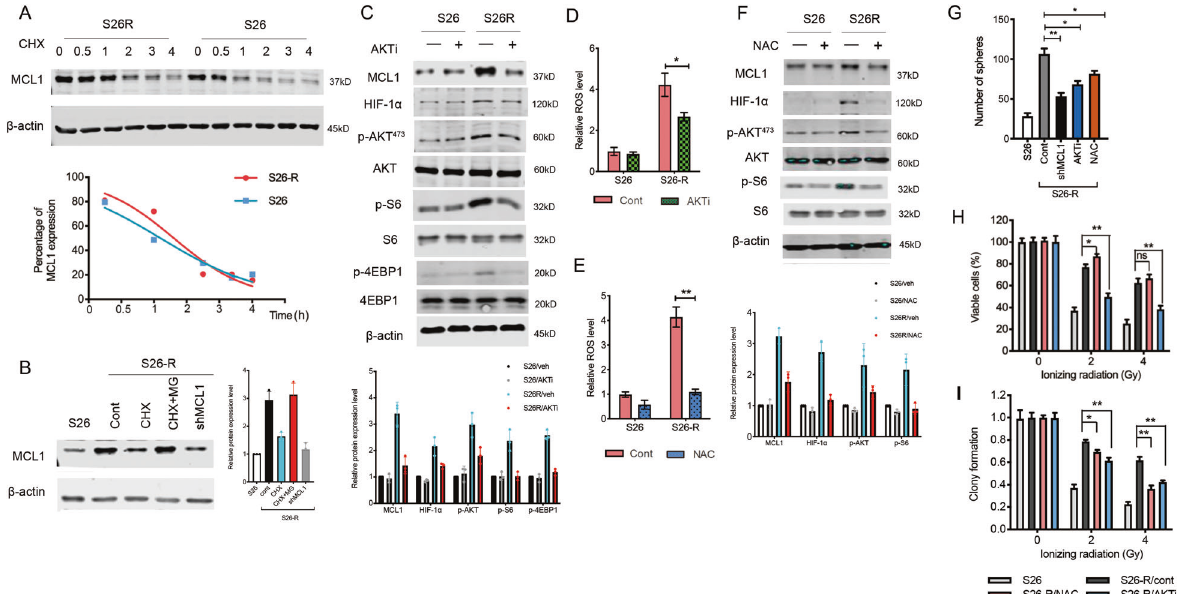
Fig. 5 ROS-AKT feedback loop activation regulates the protein synthesis of MCL-1. A S26 and S26-R cells were treated with CHX (50 μ g/mL), lysates were collected at the indicated times. (Upper) Immunoblotting analysis of MCL-1 levels. (Lower) MCL-1 levels were quanti fi ed and normalized to the signal of β -actin. B S26-R and S26 cells were treated with CHX (50 μ g/mL) or combined with MG132 (5 μ M) for 2 h. Cell lysates were subjected to western blotting. β -actin was used as the loading control. C , D S26-R and S26 cells were treated with the AKT inhibitor MK2206 (1 μ M) for 2 h, and then cell lysates were subjected to immunoblotting ( C ), β -actin was used as the loading control, and quanti fi cation of ROS levels is shown ( D ) ( n = 3); * p < 0.05, ** p < 0.01 compared with the 0 h control. E , F S26 and S26-R cells were treated with N-acetylcysteine (NAC, 5 μ M) for 2 h, E Quanti fi cation of ROS levels measured by DCFH-DA is shown ( n = 3; * p < 0.05, ** p < 0.01 compared with the 0 h control); F cell lysates were subjected to immunoblotting, β -actin was used as the loading control. G S26-R cells and s26 cells were treated with the AKT inhibitor or NAC, then the cells were cultured for 10 days, and the formed spheroids were counted and compared, ** p < 0.01, * p < 0.05, Student ’ s t -test. H , I S26-R cells and S26 cells were treated with the AKT inhibitor or NAC for 2 h, and then cells received the indicated dose of irradiation, and cell viability was determined by the MTS assay 2 days post-irradiation, and clony formation was determined by stained with methylene blue and counted 10 days post-irradiation, ** p < 0.01, * p < 0.05, Student ’ s t -test. (CHX,